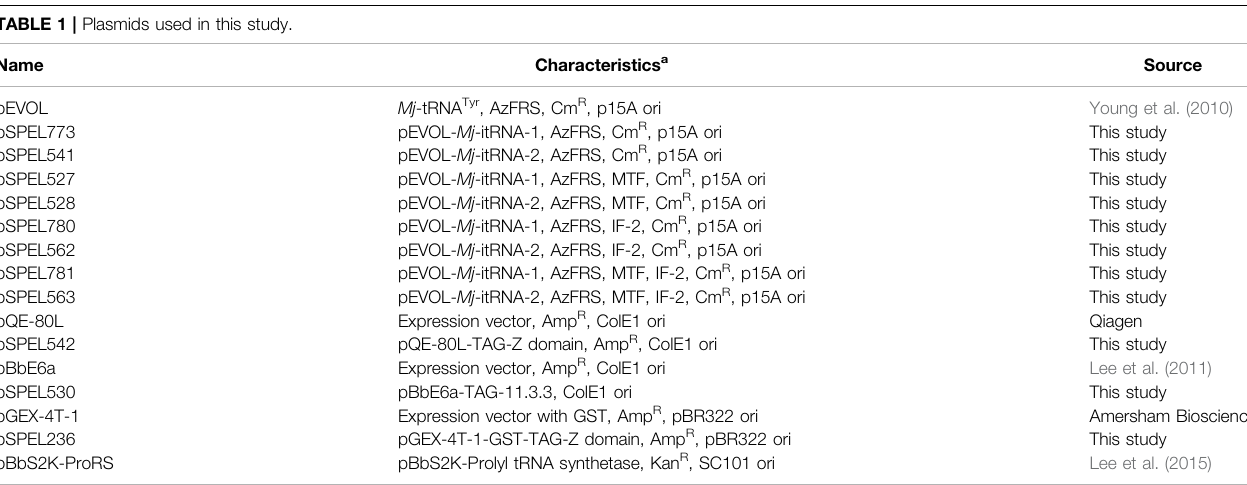
TABLE 1 | Plasmids used in this